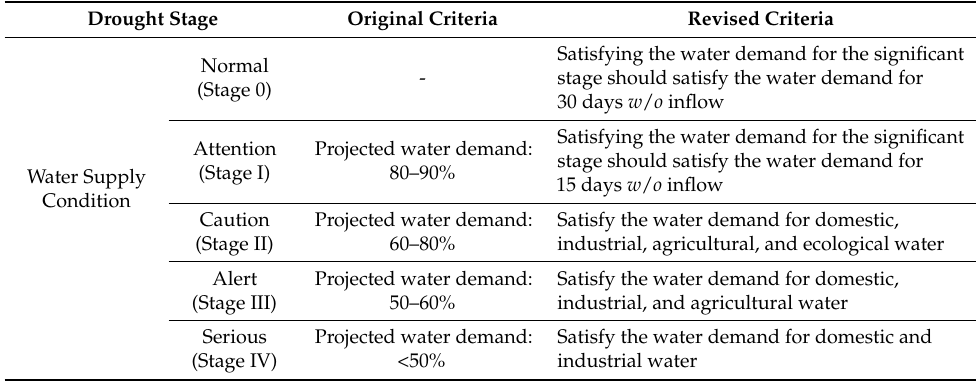
Table 2. Description of water supply conditions by each drought response stage.